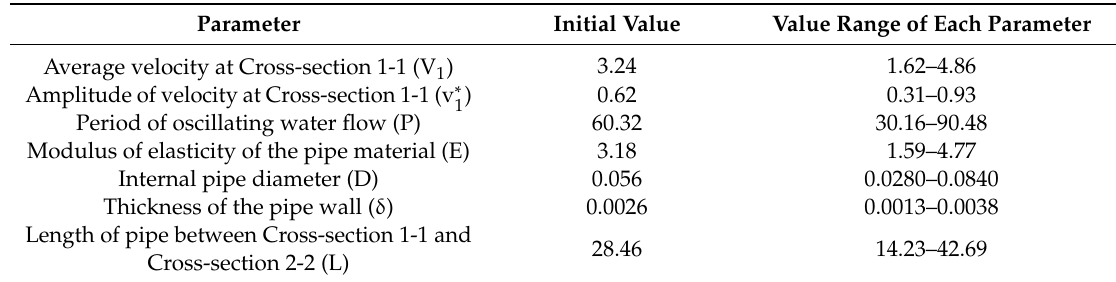
Table 8. Initial value of each parameter and the value range of each